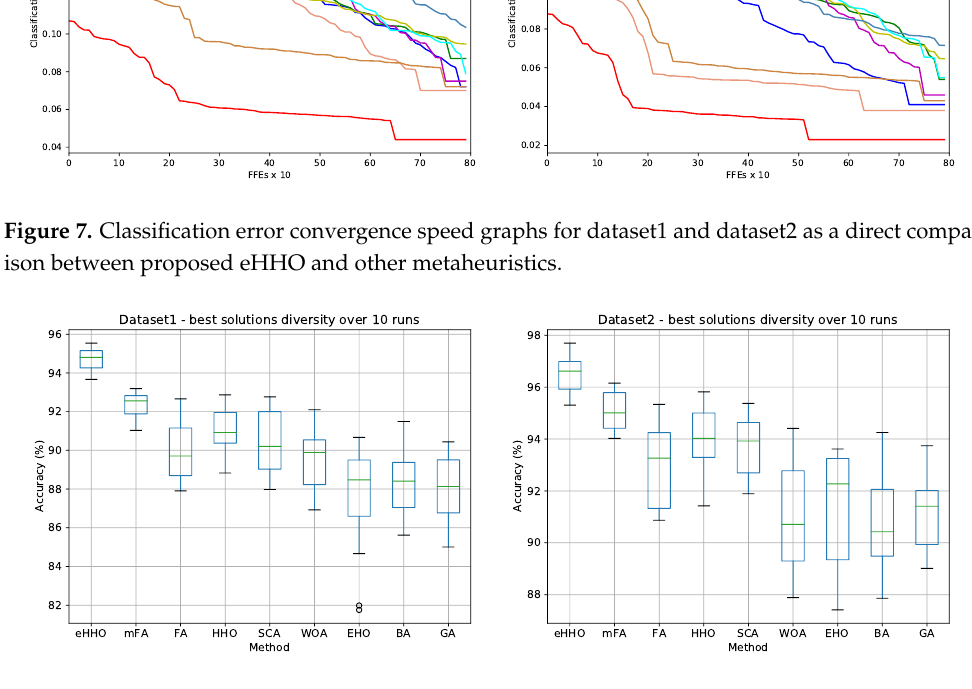
Figure 8. Diversity analysis for dataset1 and dataset2 as a direct comparison between proposed eHHO and other